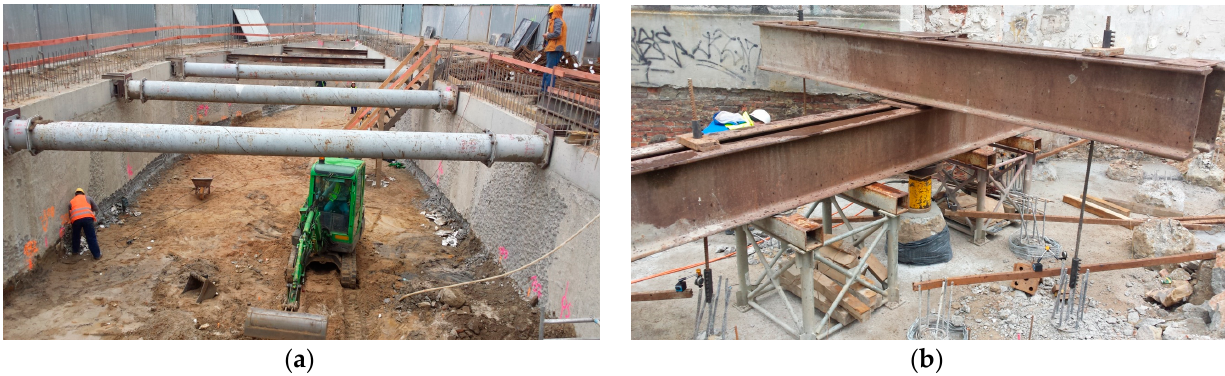
Figure 7. Realization of the underground part of building D in a support made from diaphragm walls supported by struts at a certain height ( a ) and setting part of building D on CFA piles for pile load testing ( b ).